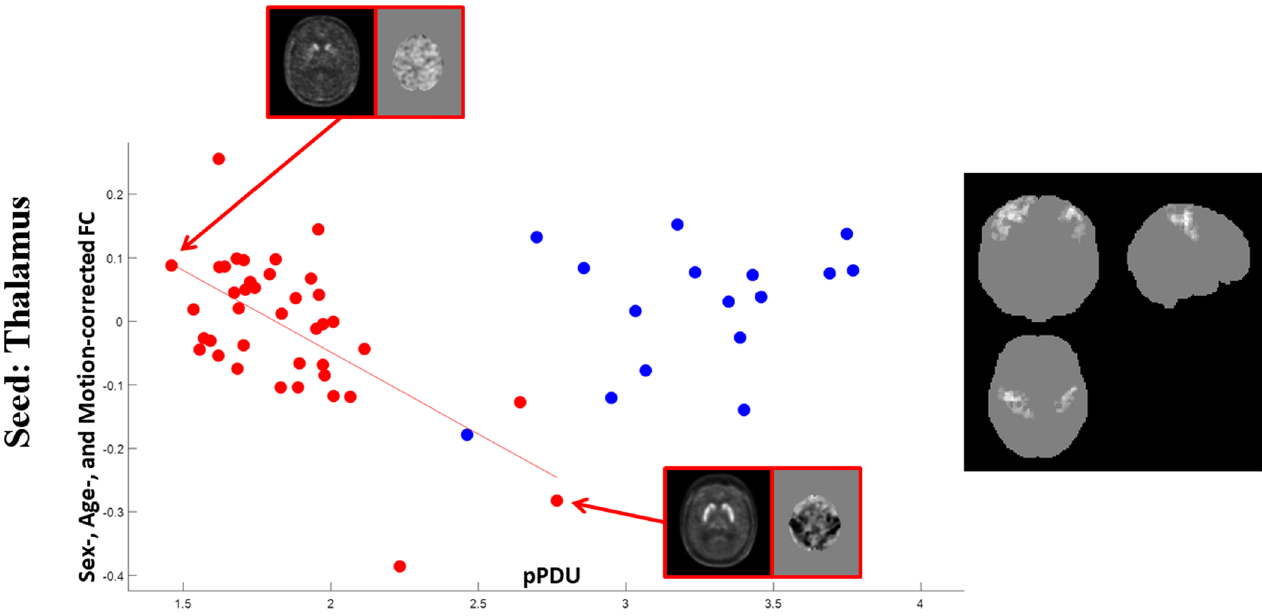
Fig. 1 Correlations of thalamic FC with pPDU. Scatterplots for PD (red) and ET (blue) patients of the mean FC of the clusters (highlighted in the inserts on the right, the most affected side is at reader ’ s left) showing a signi fi cant inverse correlation of the thalamic FC ( y axis) with pPDU ( x axis) in PD patients. For the purposes of the graph, all clusters ’ voxels were averaged as all the clusters from this contrast provided substantially overlapping patterns of correlation. FC of the thalamus on the MAS with bilateral rolandic cortices shows an inverse correlation with pPDU in PD patients, with no signi fi cant correlations in ET patients in the same regions. For demonstrative purposes, the FC maps at the level of the bilateral sensorimotor cortex of the PD patients at the extreme of the pPDU range are shown. A clear negative thalamic FC in the sensorimotor strips in the PD patient with the highest pPDU can be